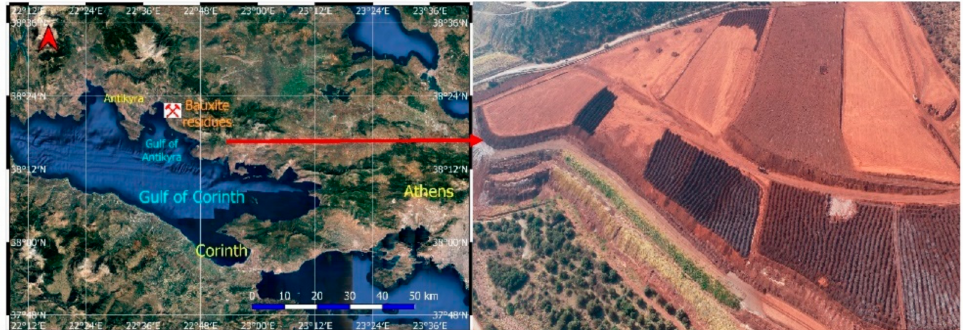
Figure 1. Location of bauxite residuals ( left ) and a high-resolution image of daily piling materi- als ( right